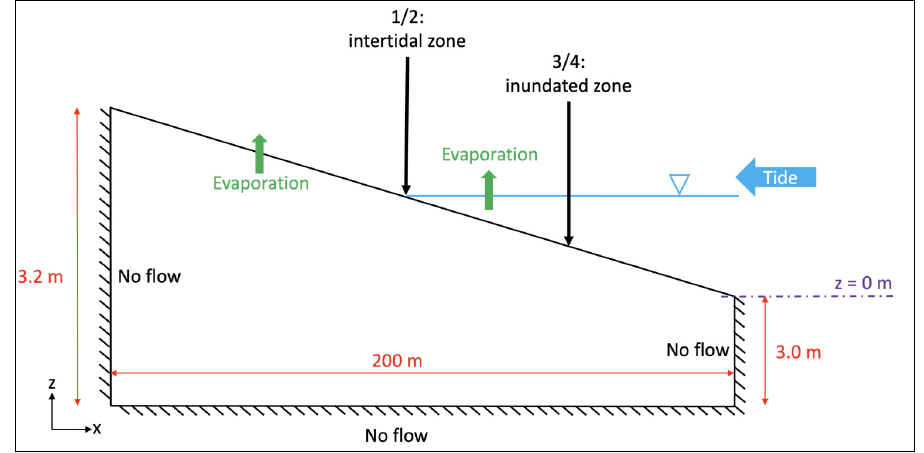
Figure 6. Model domain for the second test problem. Temporal variation of model outputs are examined at 1/2 and 3/4 of the domain length, which represents intertidal zone and fully inundated zone,